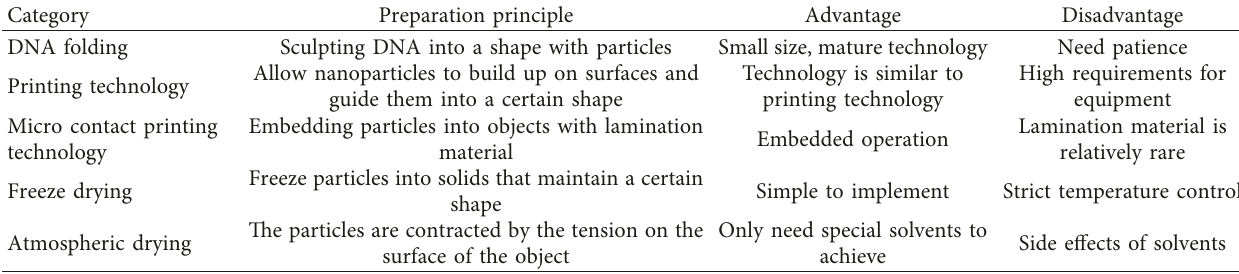
Table 1: Comparison of nanoparticle laser engraving methods.